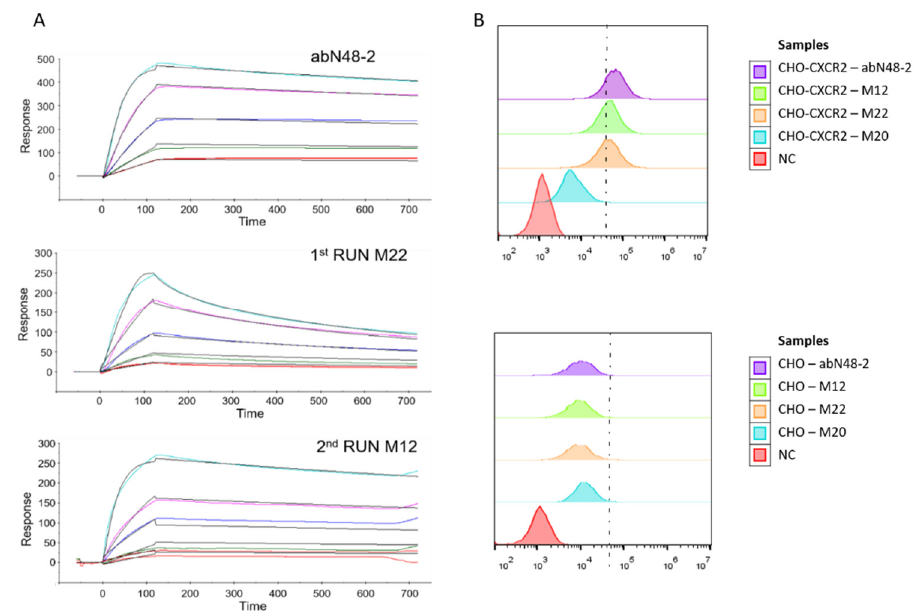
Figure 5. Experimental validation of theoretical predictions. ( A ) Binding kinetics and affinity of abN48-2, S1-M22, and S2-M12 to the peptide of extracellular N-terminal domain of human CXCR2 were determined using the SPR method (Biacore T200 system). Lines of different colors correspond to raw data obtained for different antibody concentrations (red curve: 0.5 nM, green curve: 1 nM, blue curve: 2 nM, magenta curve: 5 nM, cyan curve: 10 nM), while the black lines correspond to the best global fit). S3-M20 binding to the antigen was not detected in the experiment. ( B ) The binding ability of abN48-2, S1-M22, S2-M12, and S3-M20 to the native human CXCR2 on the surface of CXCR2-overexpressing CHO cells were evaluated using cytoflowmetry (CytoFlex). The bottom panel represents the control experiment with CHO cells not expressing CXCR2. Histograms represent the distribution of cells bound with antibodies as cell number vs. the amount of bound antibody (FL intensity—fluorophore-labeled